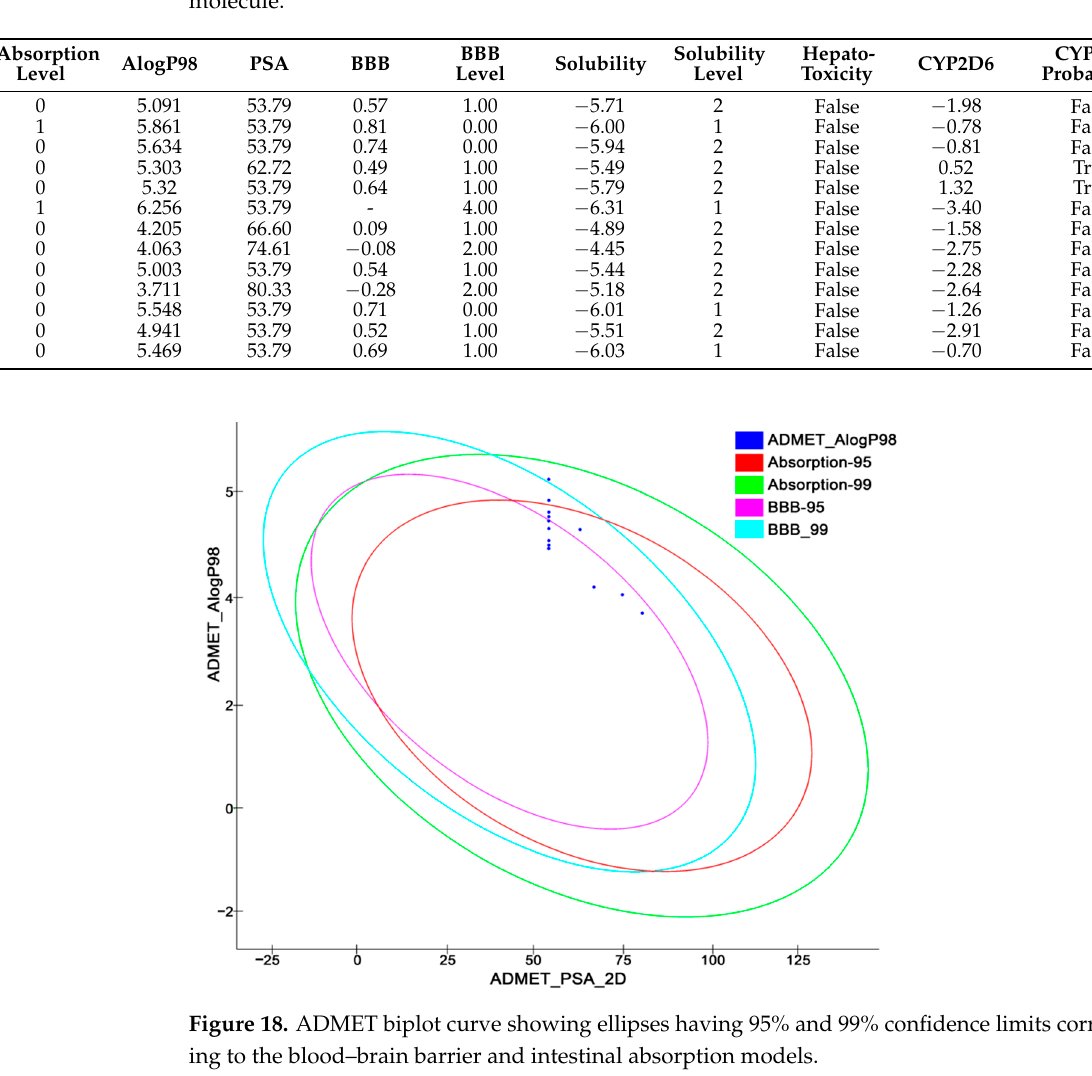
Table 6. In silico ADMET prediction of newly designed compounds and the most potent template molecule.